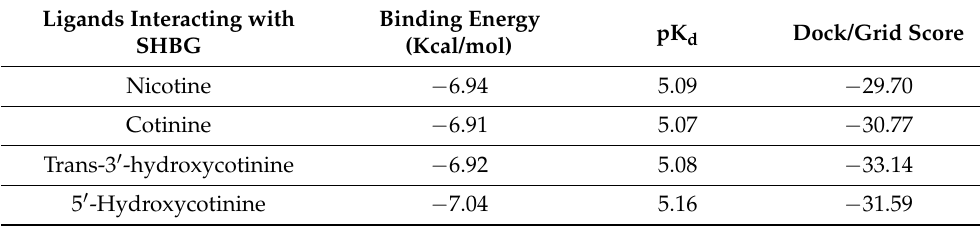
Figure 3. Molecular docking of nicotine and its three important metabolites to the ligand-binding site of sex-hormone-binding globulin (SHBG). SHBG is in surface representation colored light orange. The ligands are shown in stick representation together in the binding site for easy comparison of the binding poses. The backbones of the compounds are colored differently: native ligand (dihydrotestosterone) in white, nicotine in magenta, cotinine in cyan, trans-3 ′ -hydroxycotinine in green, and 5 ′ -hydroxycotinine in yellow. The heteroatoms of the compounds oxygen (O) and nitrogen (N) are in blue and red colors, respectively. Table 2. The binding strength scores for nicotine and its metabolites in complex with sex-hormone- binding globulin (SHBG). The ‘K d ’ denotes the dissociation constant. The binding energy and pK d or − log (K d ) values were calculated using X-Score. Lower (more negative) binding energy or Dock/Grid score and higher dissociation constant denote better docking.